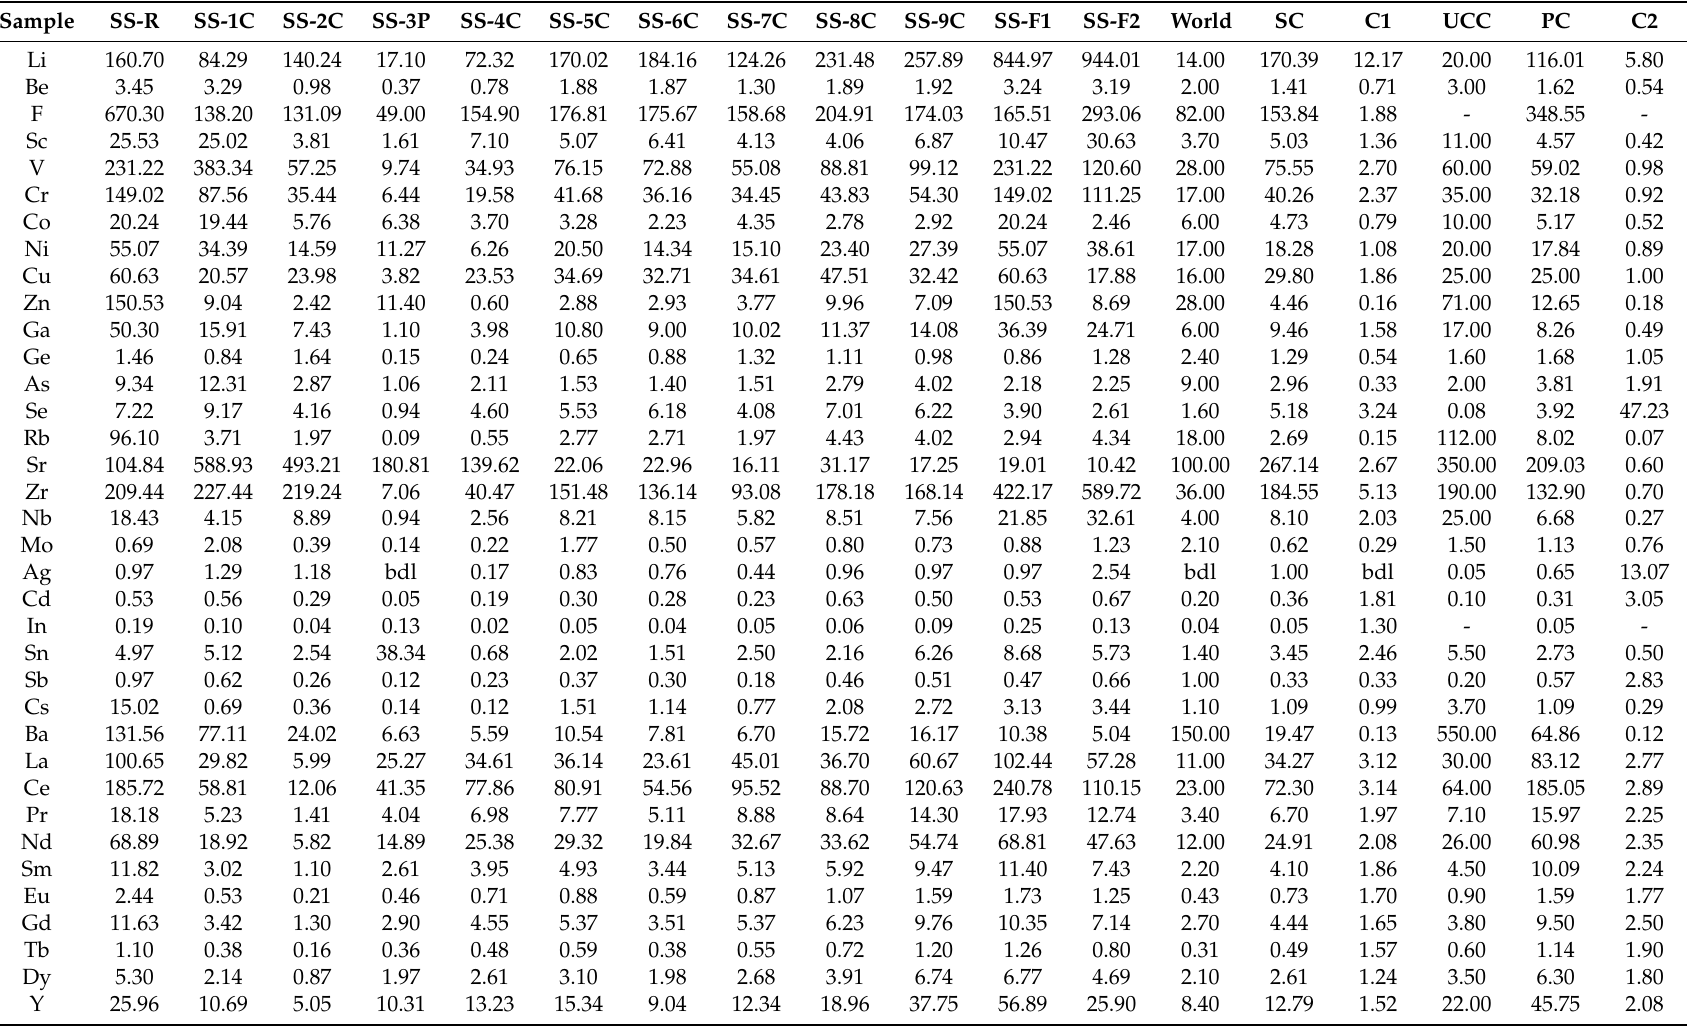
Table 3. Trace-element concentrations ( µ g/g) in the Songshao coal, parting, and roof and floor